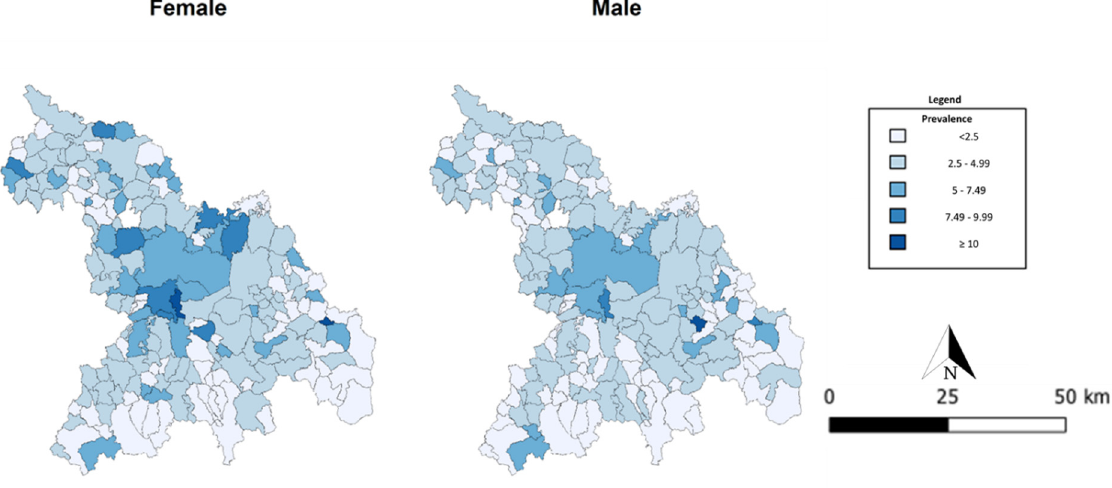
Figure A1 . Maps of the area of Alessandria LHA reporting the main towns or the towns cited in the manuscript.